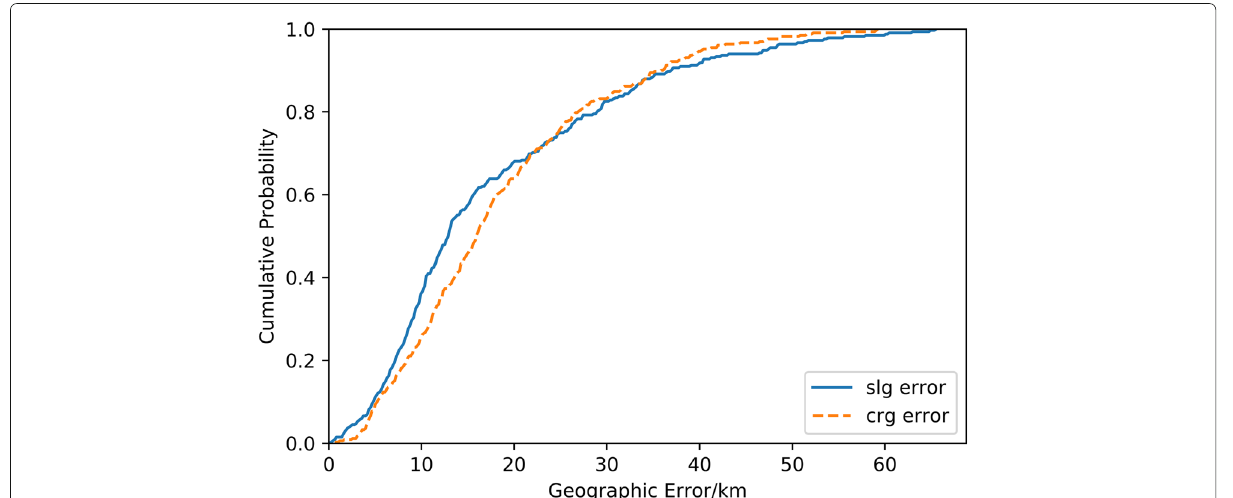
Fig. 11 Comparison of cumulative probability of SLG, CRG at city level